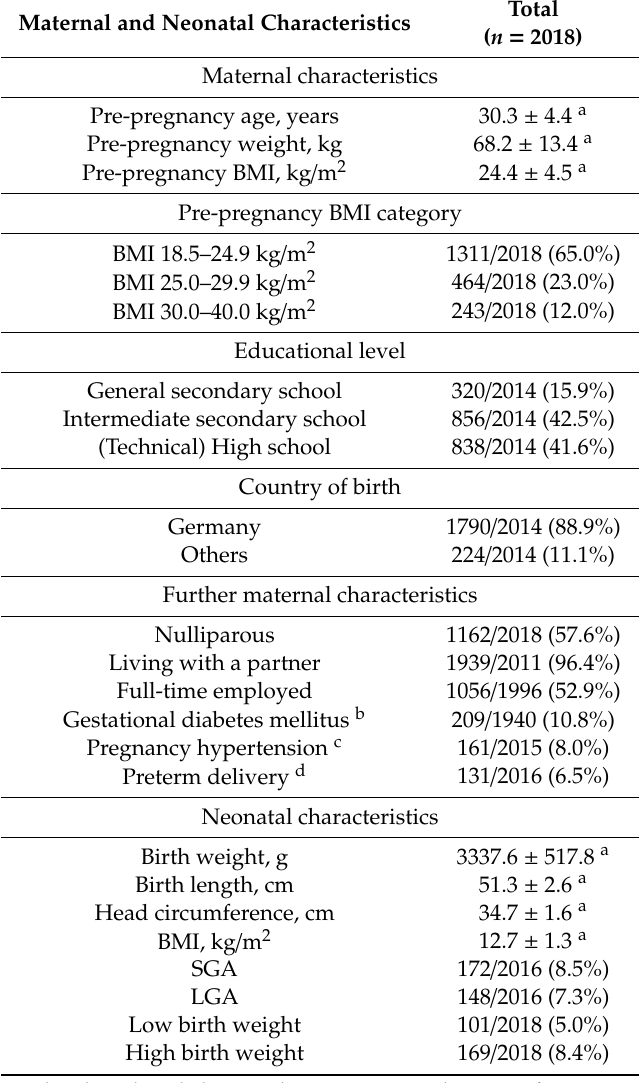
Table 1. Characteristics of study participants eligible for cohort analyses.